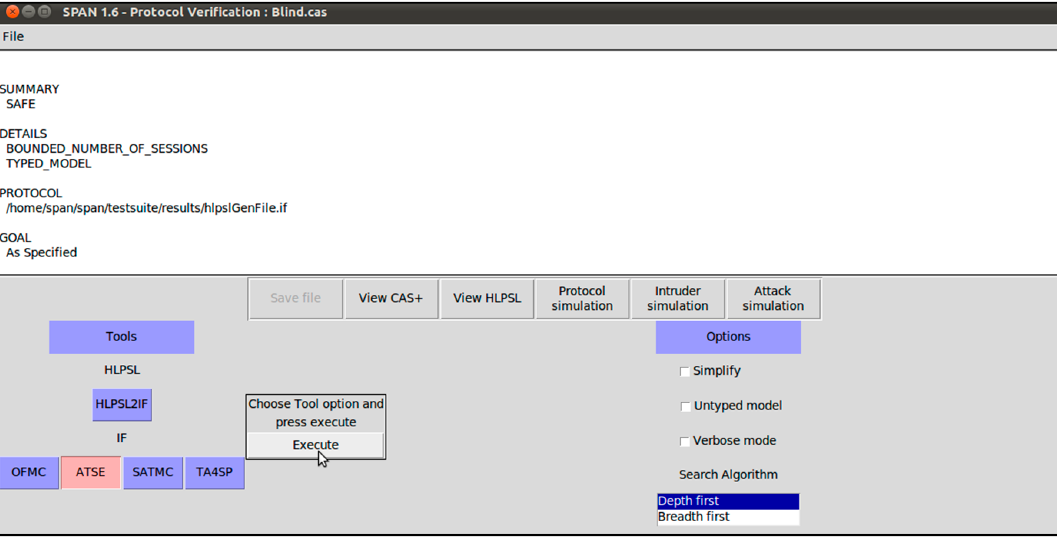
Figure A2. Simulation results for AtSe.